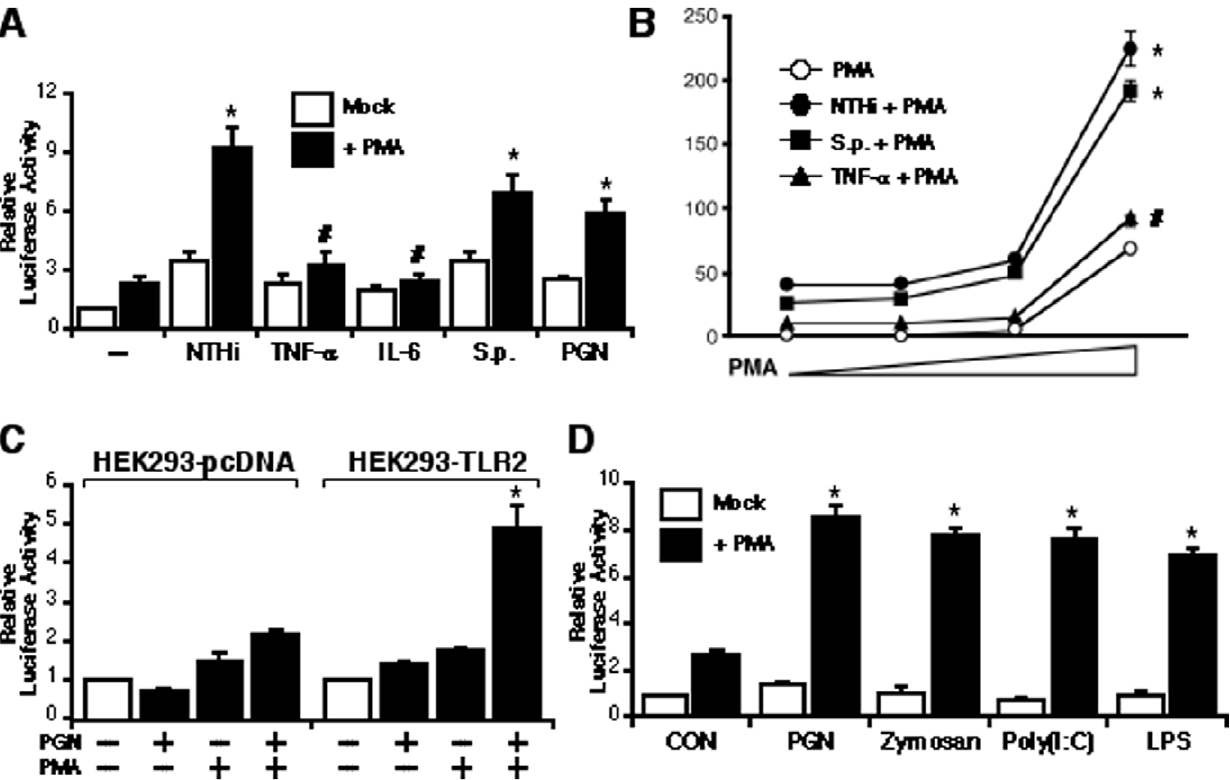
Figure 4. PMA synergistically enhances up-regulation of MUC5AC induced by activation of TLR signaling. ( A ) PMA synergistically enhanced MUC5AC expression induced only by NTHi, S.p. and PGN, but not by TNF- a and IL-6, as assessed by MUC5AC-dependent promoter Luciferase assay. Values are the means 6 S.D. (n=3). *p , 0.05 vs. NTHi, S.p. , or PGN alone; # p . 0.05 vs. TNF- a or IL-6 alone. ( B ) PMA synergized with either NTHi or S.p. , but not with TNF- a to enhance MUC5AC expression in a dose-dependent manner. Values are the means 6 S.D. (n=3). *p , 0.05 vs. PMA alone; # p . 0.05 vs. PMA alone. ( C ) PGN-induced MUC5AC transcription was synergistically enhanced by PMA in HEK293-TLR2 cells, but not in HEK293-pcDNA cells. Values are the means 6 S.D. (n=3). *p , 0.05 vs. PGN alone. ( D ) Synergistic enhancement of MUC5AC expression by PMA was also observed in the cells treated with TLR ligands, such as PGN, Zymosan, Poly(I:C) and LPS, respectively. Values are the means 6 S.D. (n=3). *p , 0.05 vs. PGN, Zymosan, Poly(I:C), or LPS alone. The data shown are representative of three independent experiments. 2 , absence of; + , presence of; S.p.